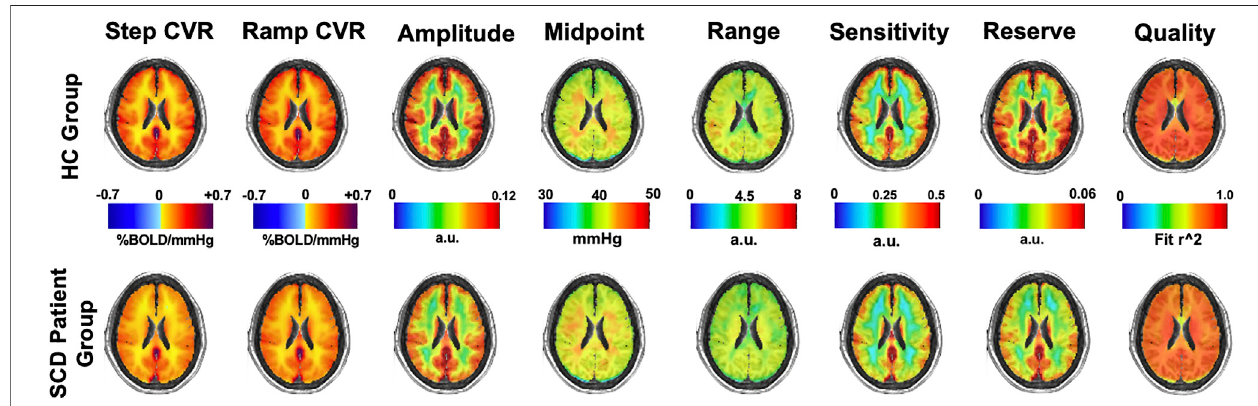
FIGURE 3 | Mean CVR (two left images) and resistance parameters (remaining six images) for the HC and SCD patient groups.